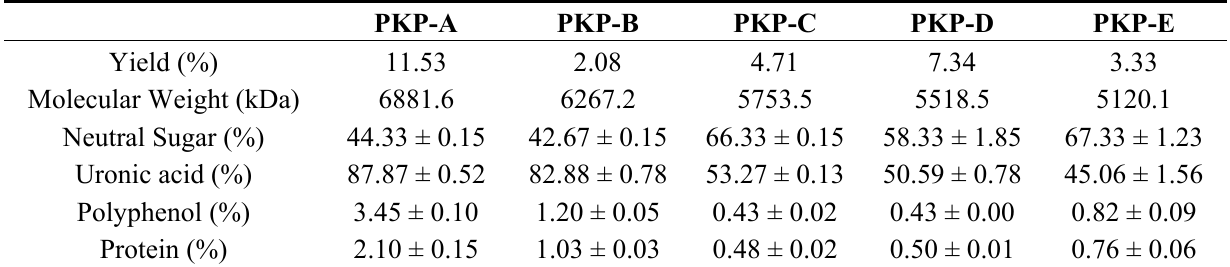
Table 1. Yield, molecular weight, content of neutral sugar and protein of PKPs ( n = 3).